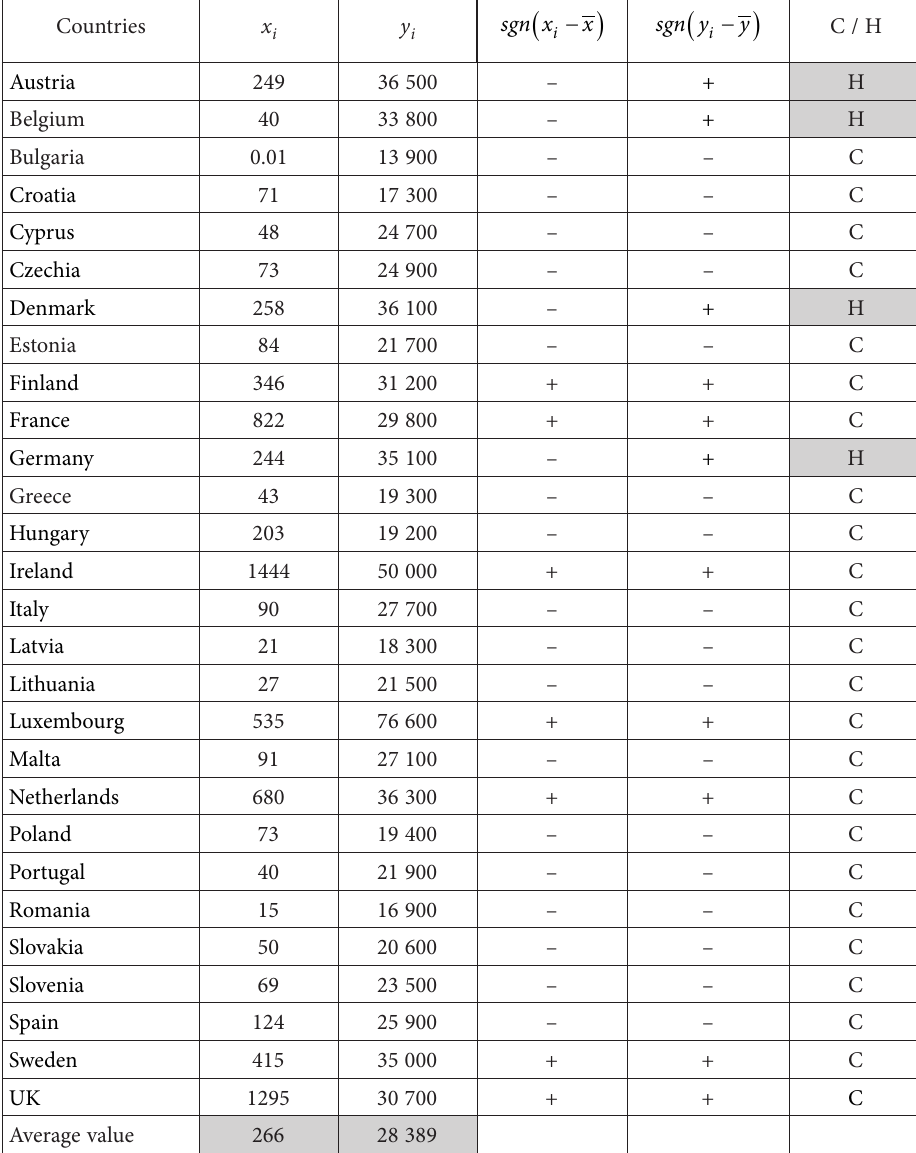
Table 3. Correlation between vocational training costs and GDP per capita ( source: Own calculations based on Eurostat, 2020a, 2020b)